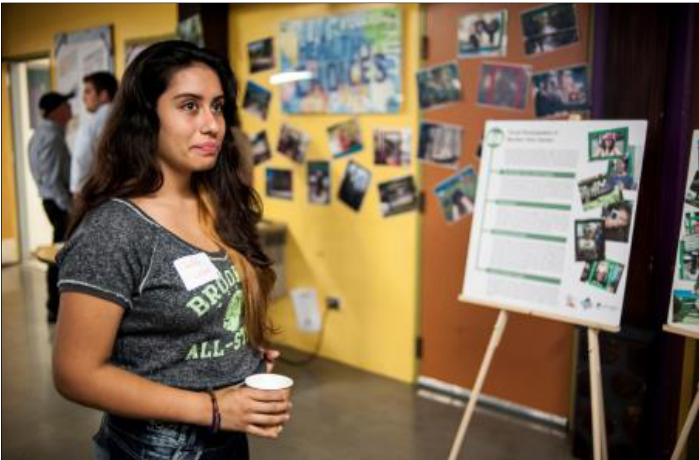
Figure 7. A “Dreamer” presenting results of the photovoice project at a public meeting for the Civic Area (photo courtesy of Stephen